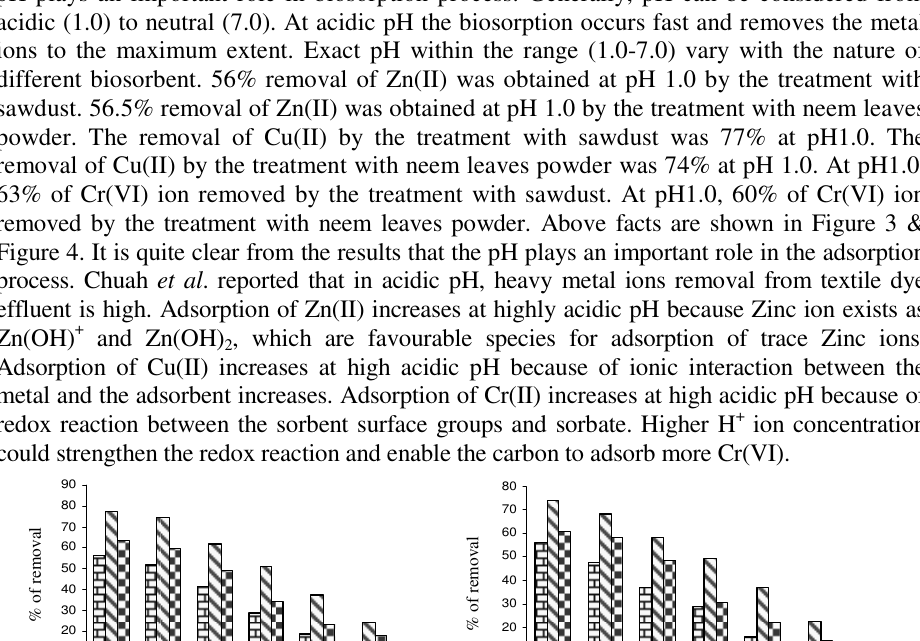
Figure 4. Effect of pH on the removal of Zn(II), Cu(II) and Cr(VI) by neem leaves Condition: T = 23 o C and t = 60 minutes